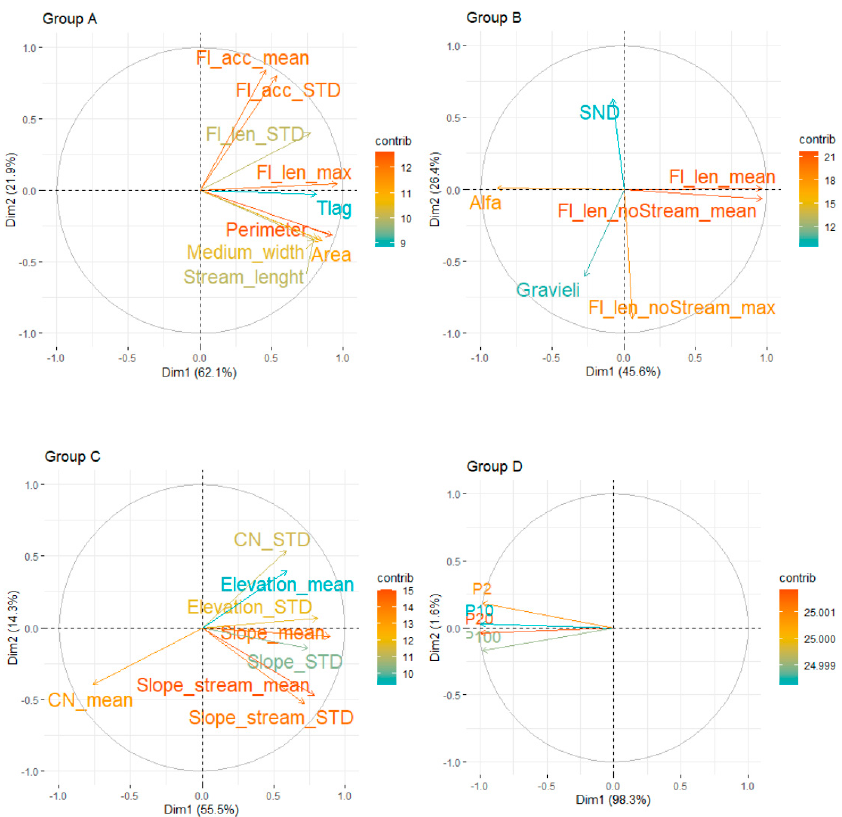
Figure A1. Biplots of the first two dimensions of the PCA analysis for Groups A – D